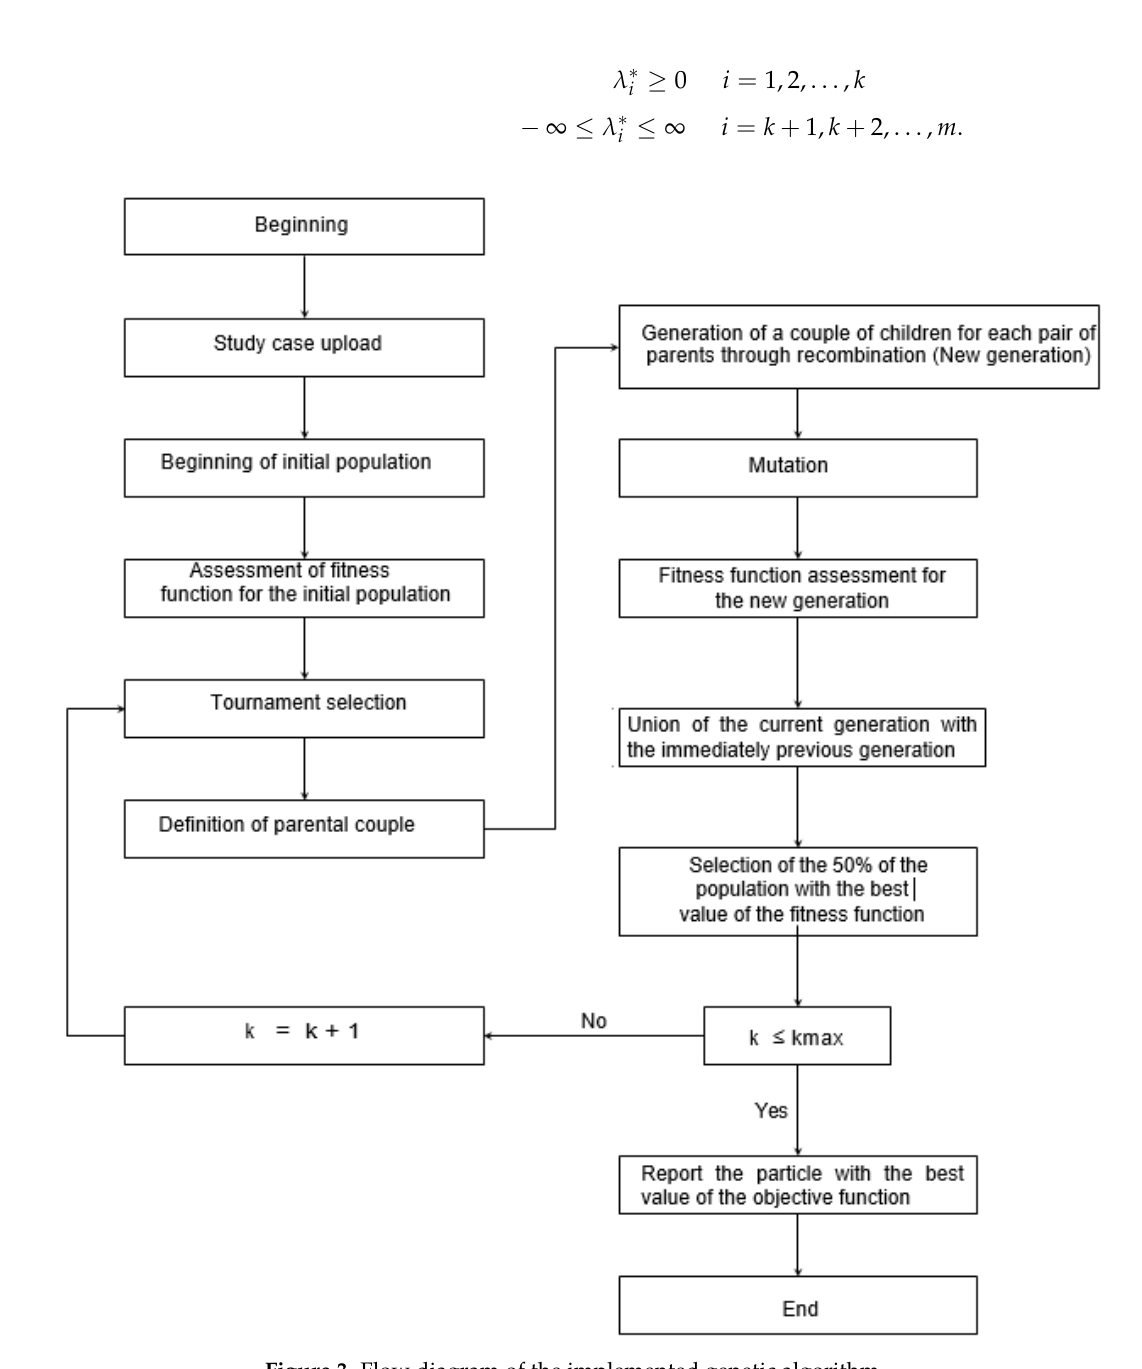
Figure 3. Flow diagram of the implemented genetic